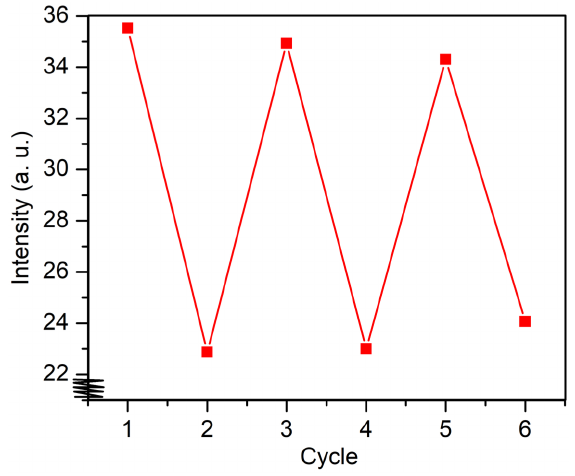
Figure 6: Reversibility testing with changes in fluorescent intensity of SBA-15/APTES-NH at 533 nm upon addition to KSCN in HCl